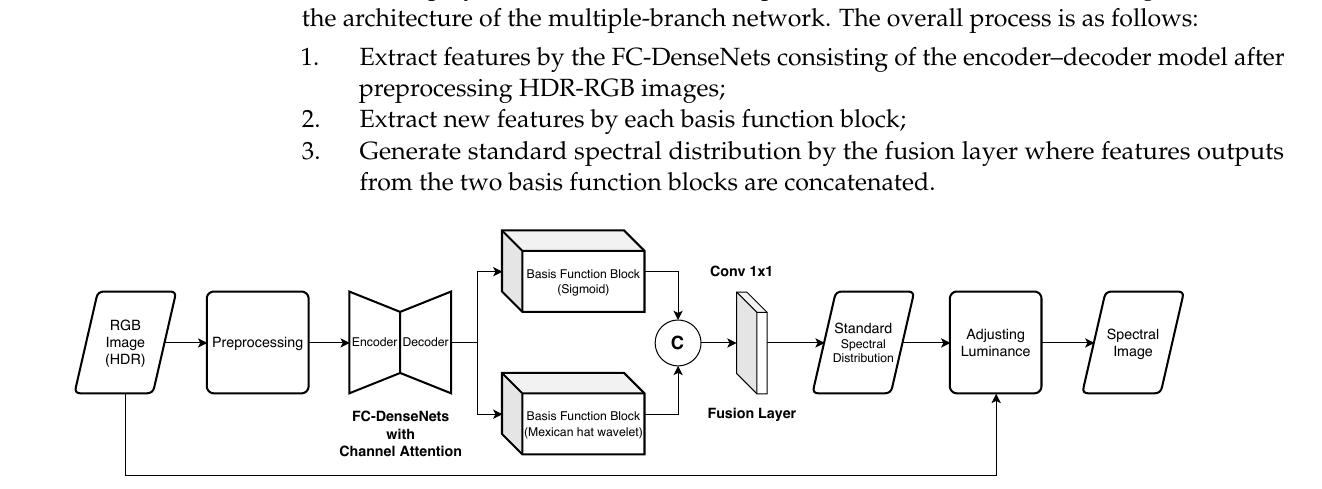
Figure 3. The architecture of the multiple-branch network.